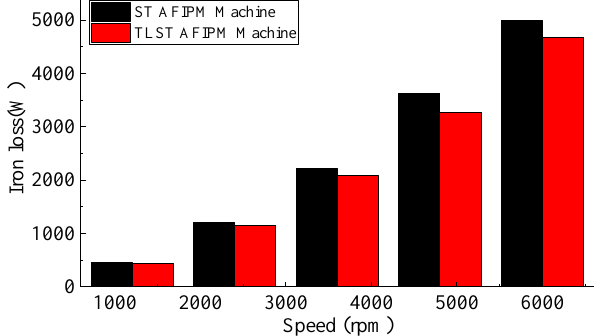
Figure 17. Stator iron losses at different speed at no-load.